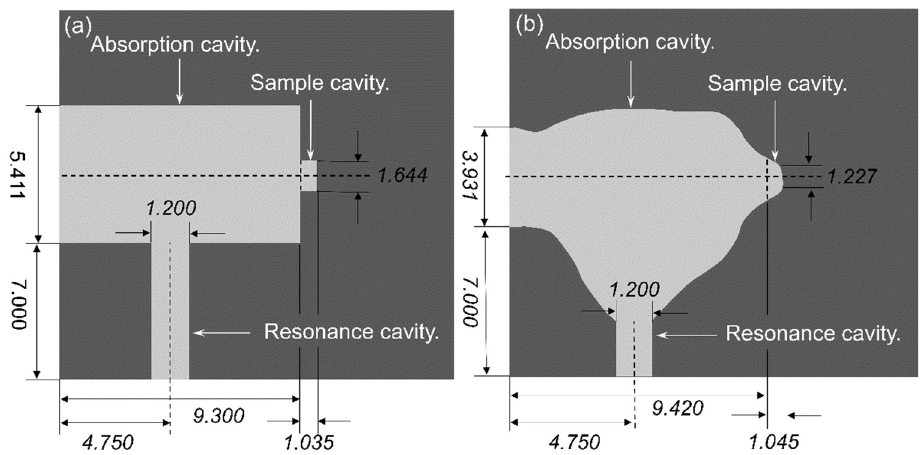
Figure 3. The schematic of two cells cross-section (shown as light grey areas): ( a ) conventional cell and ( b ) “cardiac-type” cell. All numbers have the unit of mm.